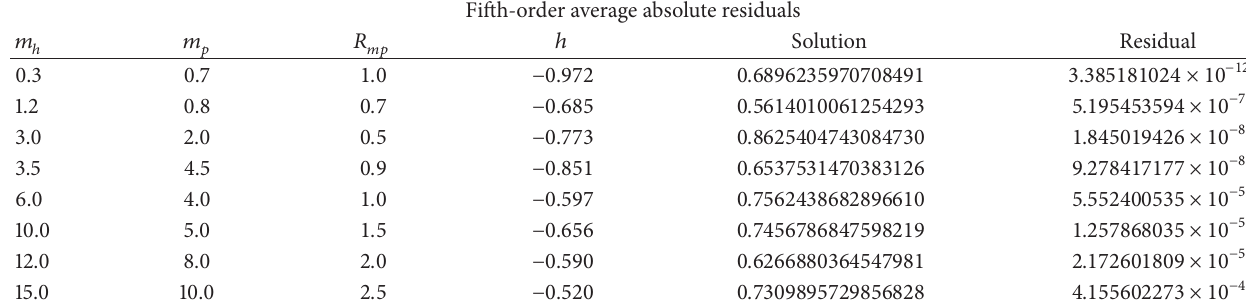
Table 6: Average absolute residuals for various values of 𝑚 ℎ , 𝑚 𝑝 , 𝑅 𝑚𝑝 , and ℎ .